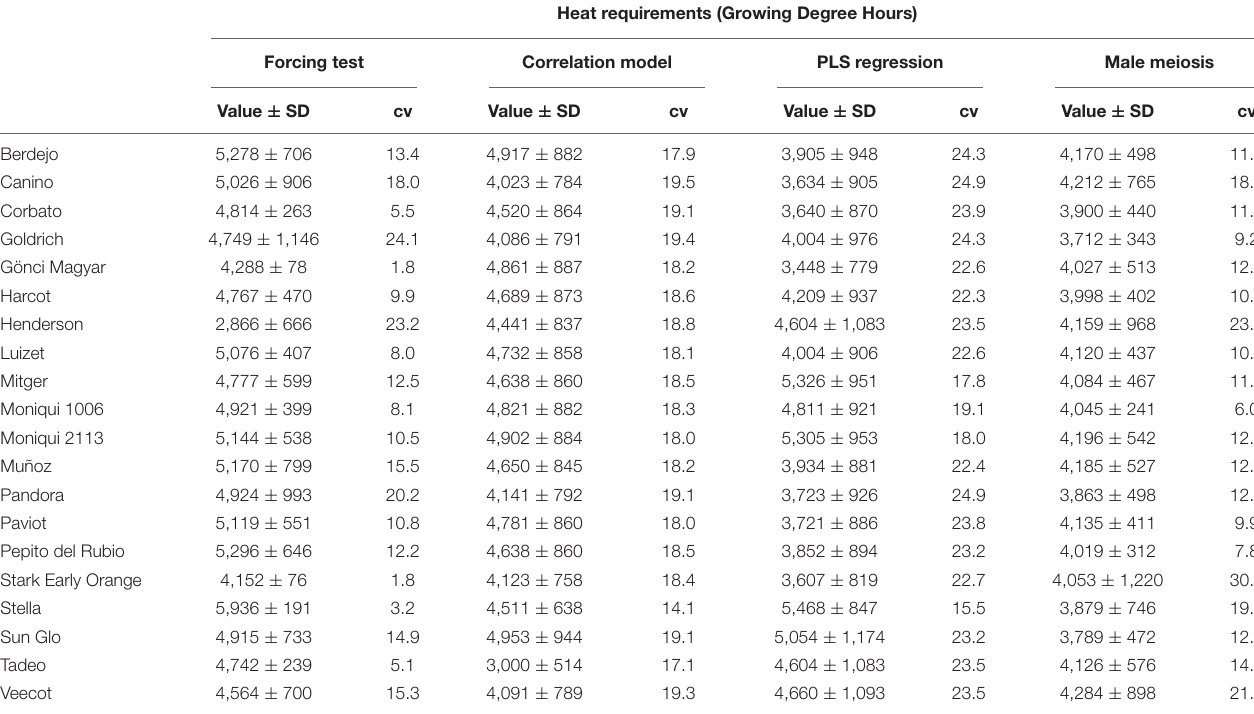
TABLE 3 | Heat requirements from the end of endodormancy to full flowering of 20 apricot cultivars determined according to four methods (forcing test, correlation model, PLS, and male meiosis